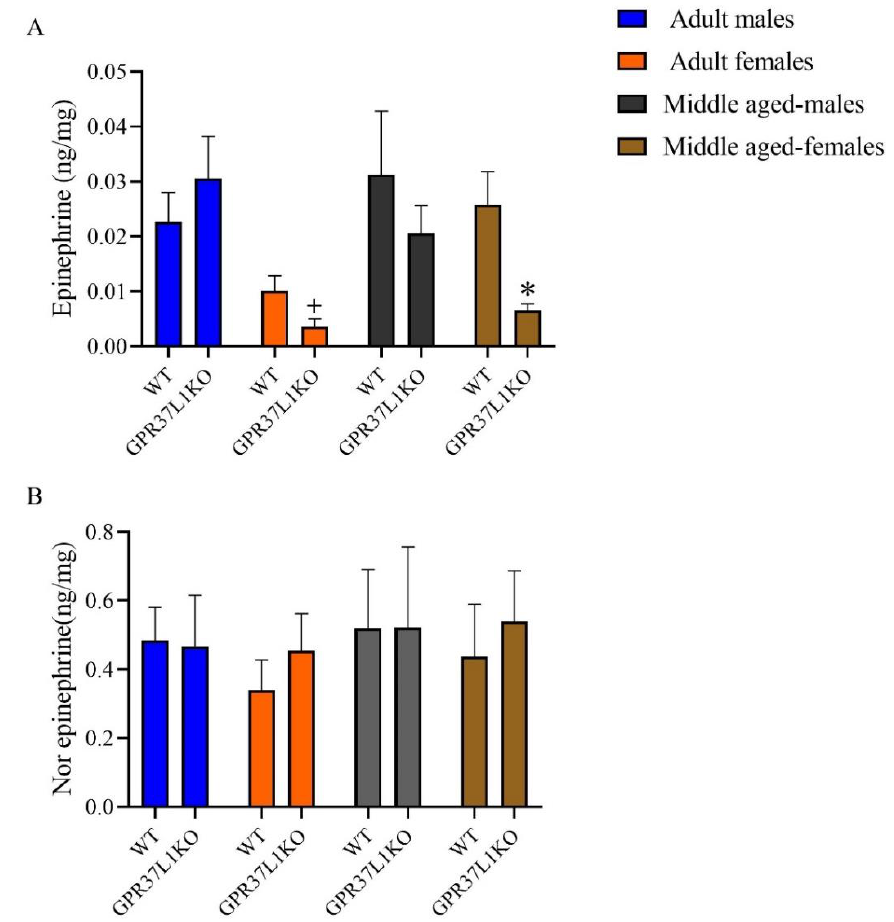
Figure 5. Effect on the level of epinephrine and nor epinephrine in the dorsal hippocampus in adult and middle-aged WT and GPR37L1KO males and females after PAT. Epinephrine in the dorsal hippocampus ( A ) Nor epinephrine in the dorsal hippocampus ( B ) n /group: 5 to 9. All data represent mean ± SD. * p < 0.05 within genotype; + p < 0.05 with respect to sex calculated by three-way ANOVA, followed by multiple comparisons using the two-stage linear step-up procedure of Benjamini, Krieger and Yekutieli.